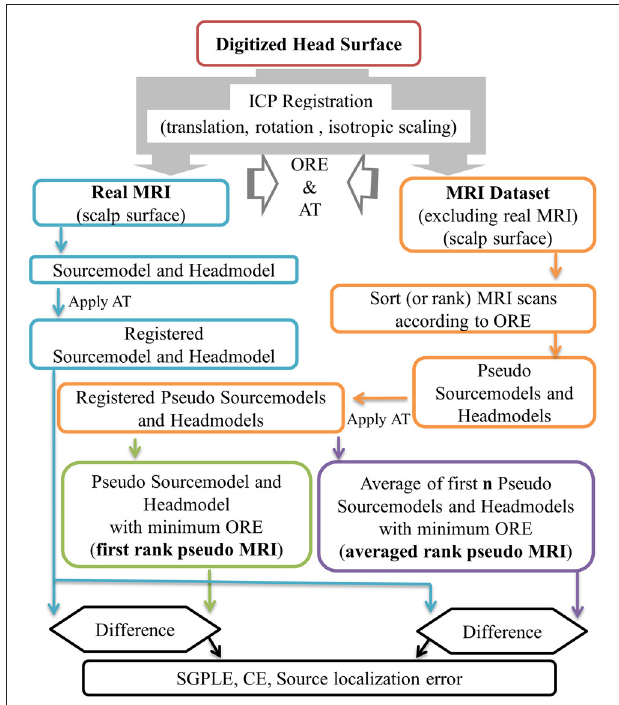
FIGURE 1 | Outline of first rank pseudo MRI and averaged rank pseudo MRI approximation, and related error estimation. ORE, objective registration error; AT, affine transformation; SGPLE, source grid point location error; CE, Centroid